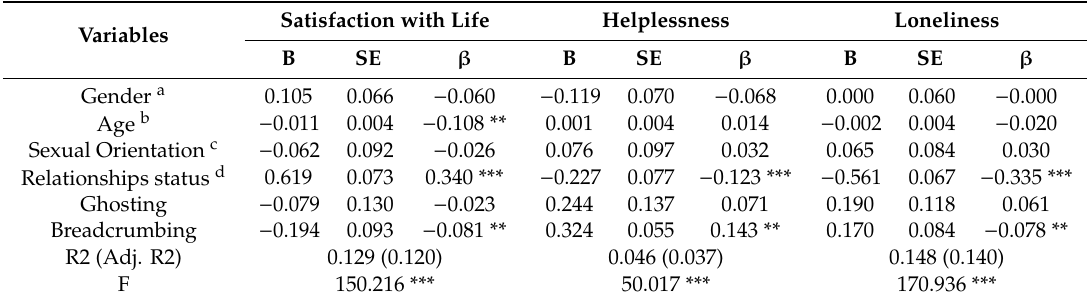
Table 3. Regression analyses examining the associations of ghosting and breadcrumbing with psychological constructs as the